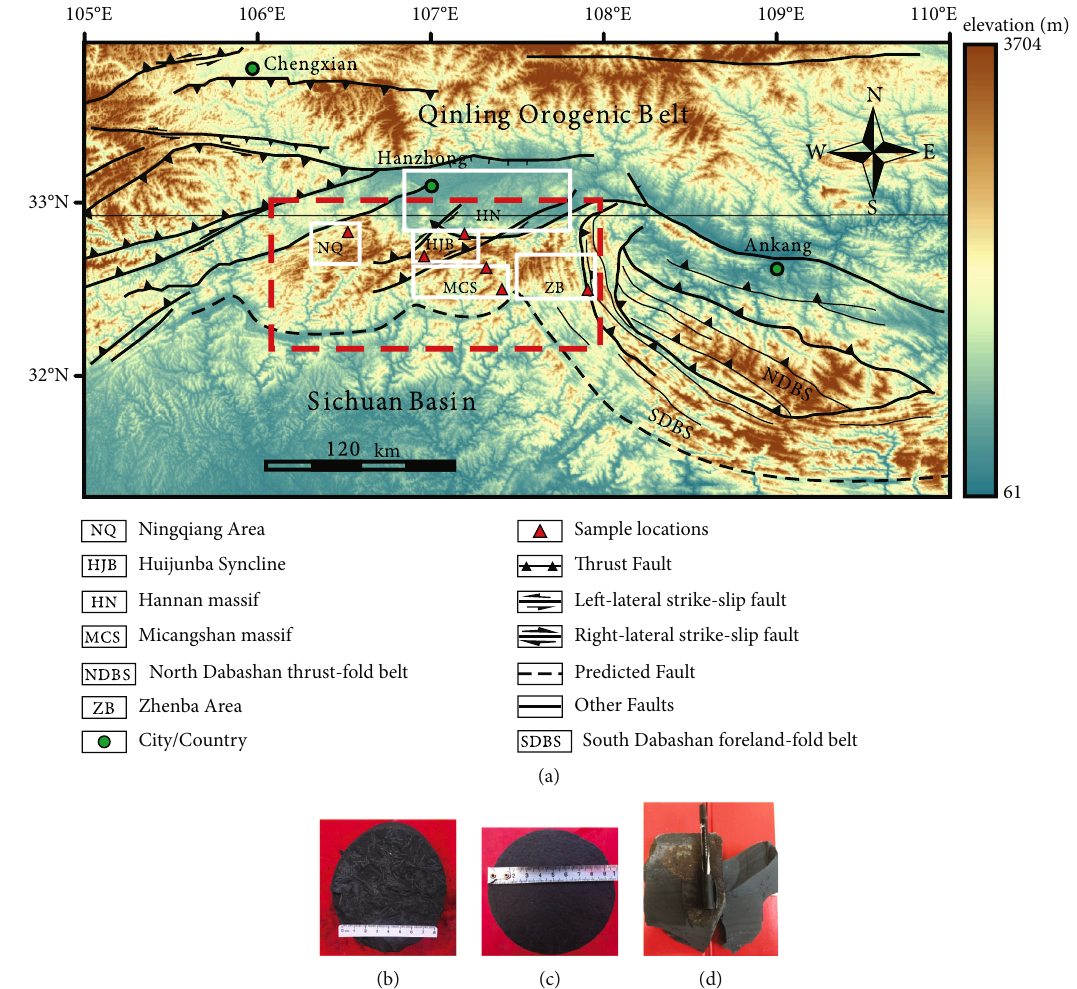
Figure 1: (a) Geological sketch map of the study area and sampling location; (b) black carbonaceous shale of Longmaxi Formation with graptolites; (c) black carbonaceous shale of Niutitang Formation; (d) silty shale of Doushantuo